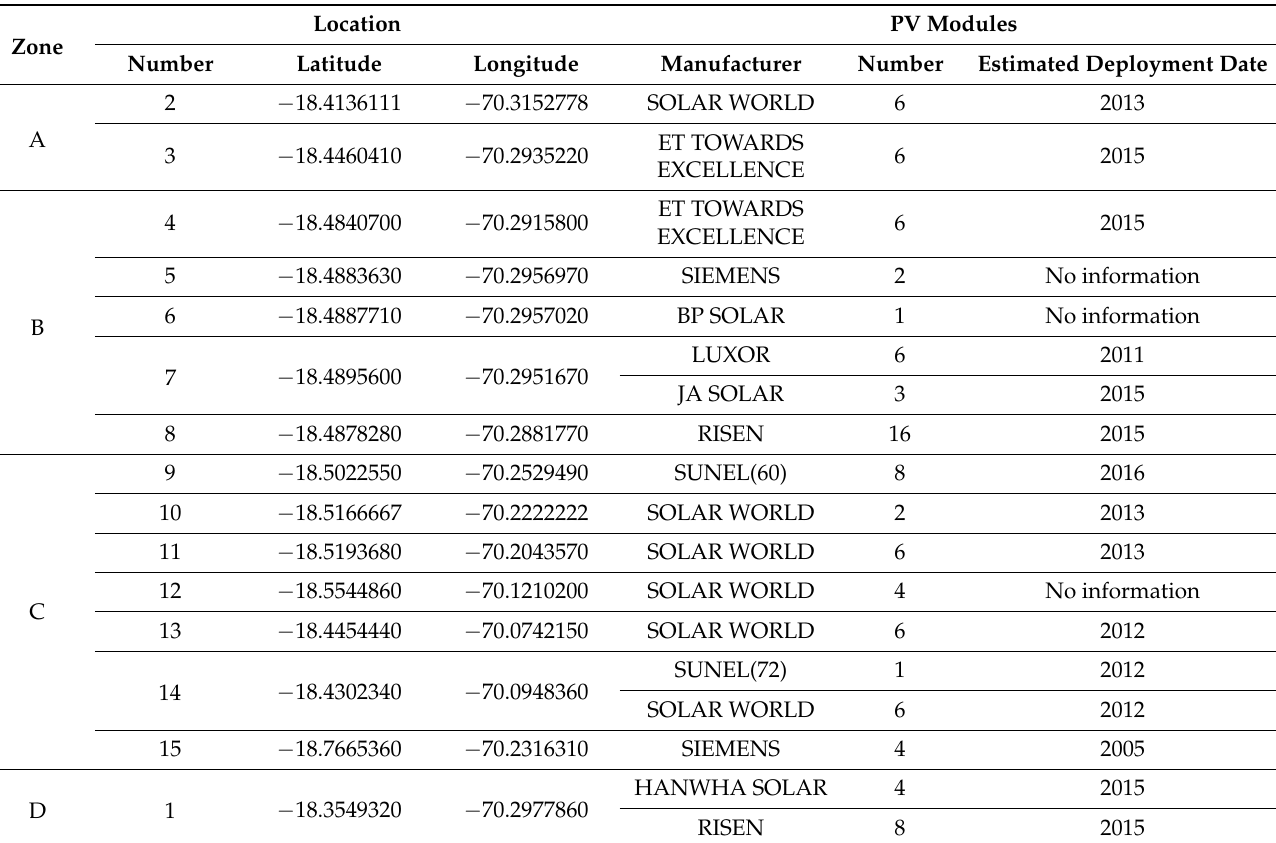
Table A2. Summary of inspected